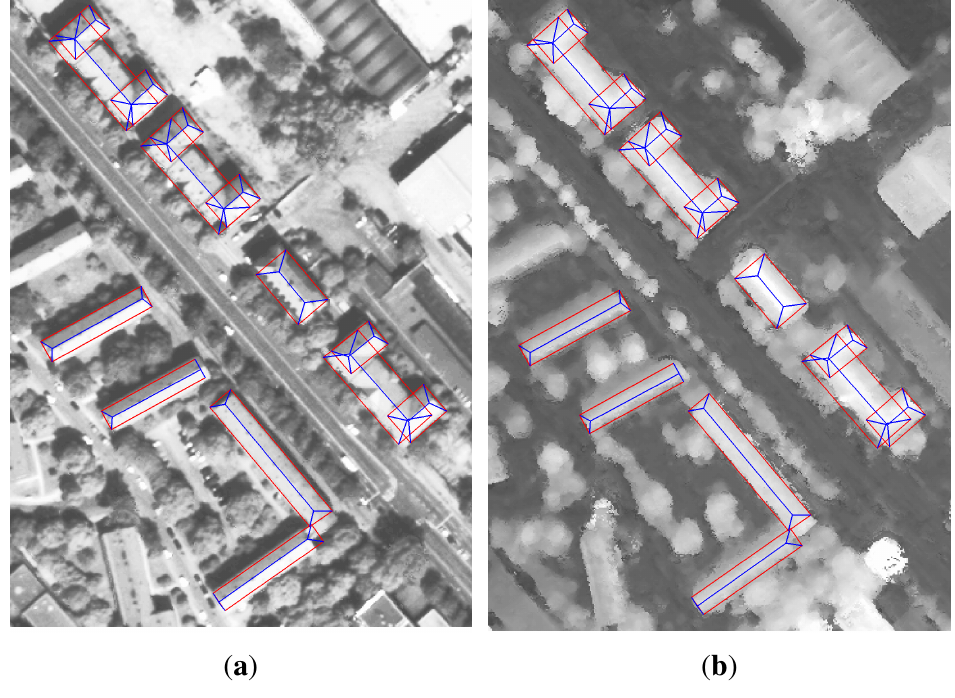
Figure 16. Automatically generated 3D building models superimposed on ( a ) orthorectified Worldview image and ( b ) DSM. (a) Final refined models superimposed on orthorectified image; (b) Final refined models superimposed on DSM image.